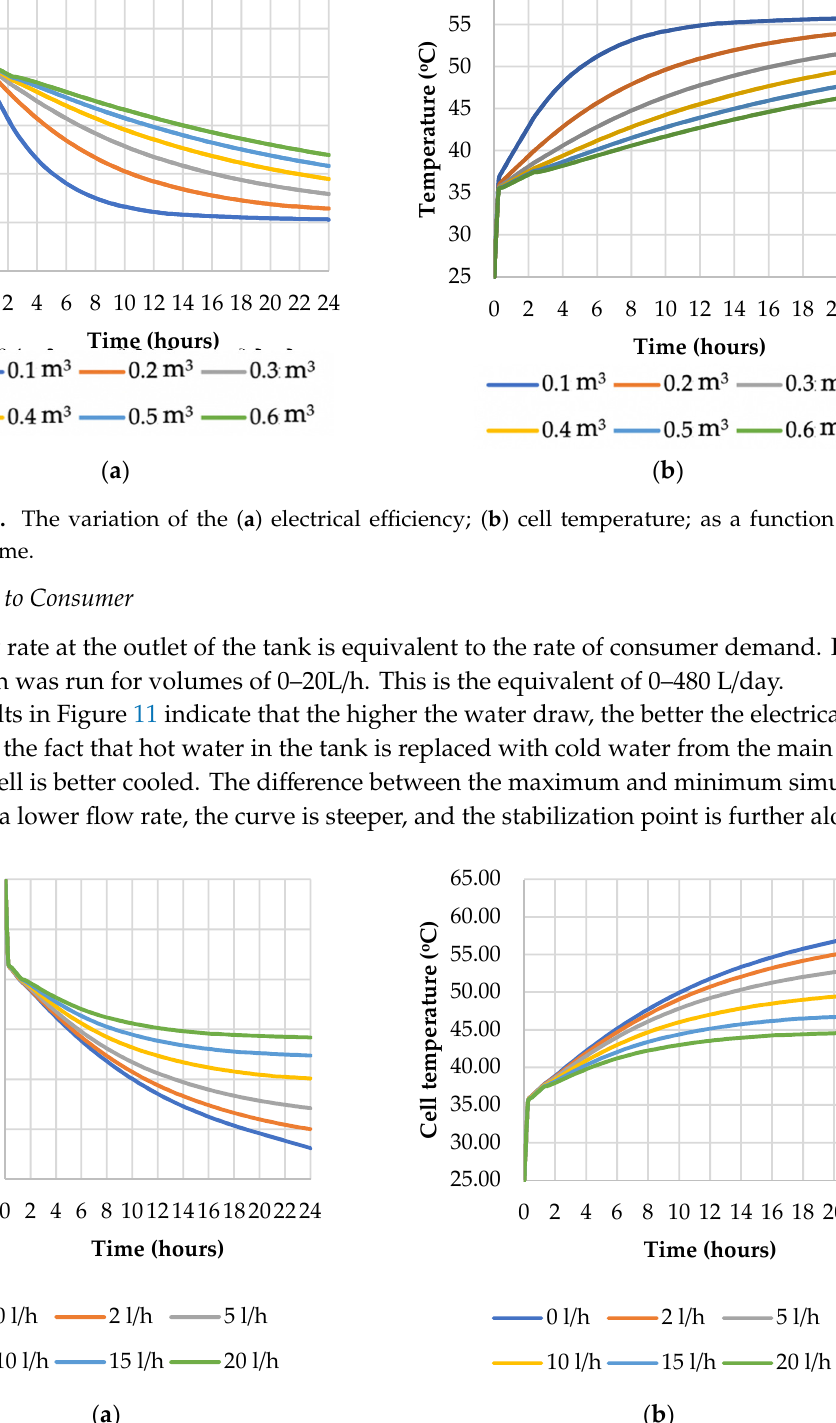
( b ) Figure 9. The variation of the ( a ) electrical efficiency; ( b ) cell temperature; during a typical summer day in Bucharest, Romania. 3.2. Tank Volume The default volume of the modelled tank is 600l. For the parametric variation, the tank is scaled down to 100l, with increments of 100l up to 600l. The results of the simulations are shown in Figure 10. In this case, the difference between the steps is not proportional as observed for the inlet temperature. With the smallest tank size, a steep decrease in efficiency occurs, followed by a flat curve